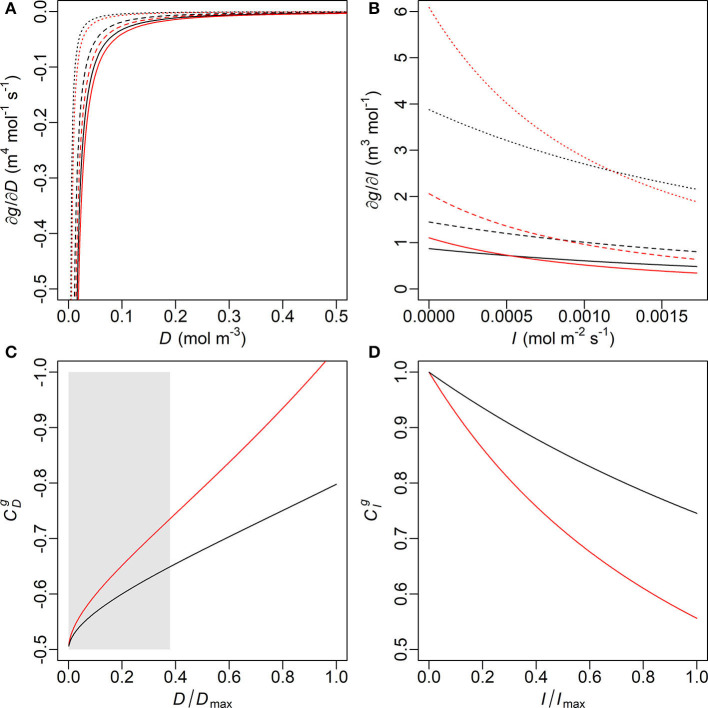
Partial derivatives of stomatal conductance (g) with respect to (A, top left) vapour deficit (D) and (B, top right) photosynthetic photon flux density (I) and the relative sensitivity coefficients (C, bottom left) CDg (with reversed y-axis) and (D, bottom right) CIg, calculated with the maxima a posteriori (MAP) estimates of λ, ι and γ of the young (red) and old (black) sample trees (Table 3A). Solid, dashed and dotted lines designate the conditions that the other variable [I in (A), D in (B)] is held constant at its level of 100, 50, and 10% maximum of the measurement period, respectively. Such maxima values are noted as Dmax and Imax in (C) and (D), respectively. Only limited ranges of D and ∂g/∂D are displayed in (A) for visual clarity, which correspond to the grey box in (C).